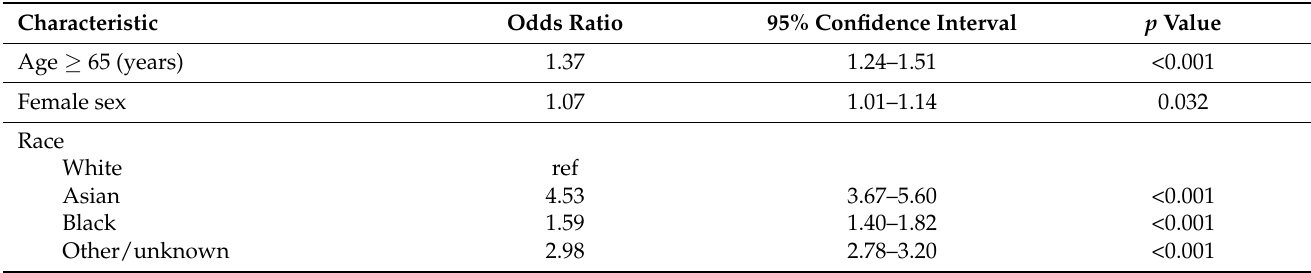
Table 3. Multivariable logistic regression analysis of factors associated with minimally invasive surgical approach among lung lobectomy patients in the Premier Healthcare Database from 2009 to